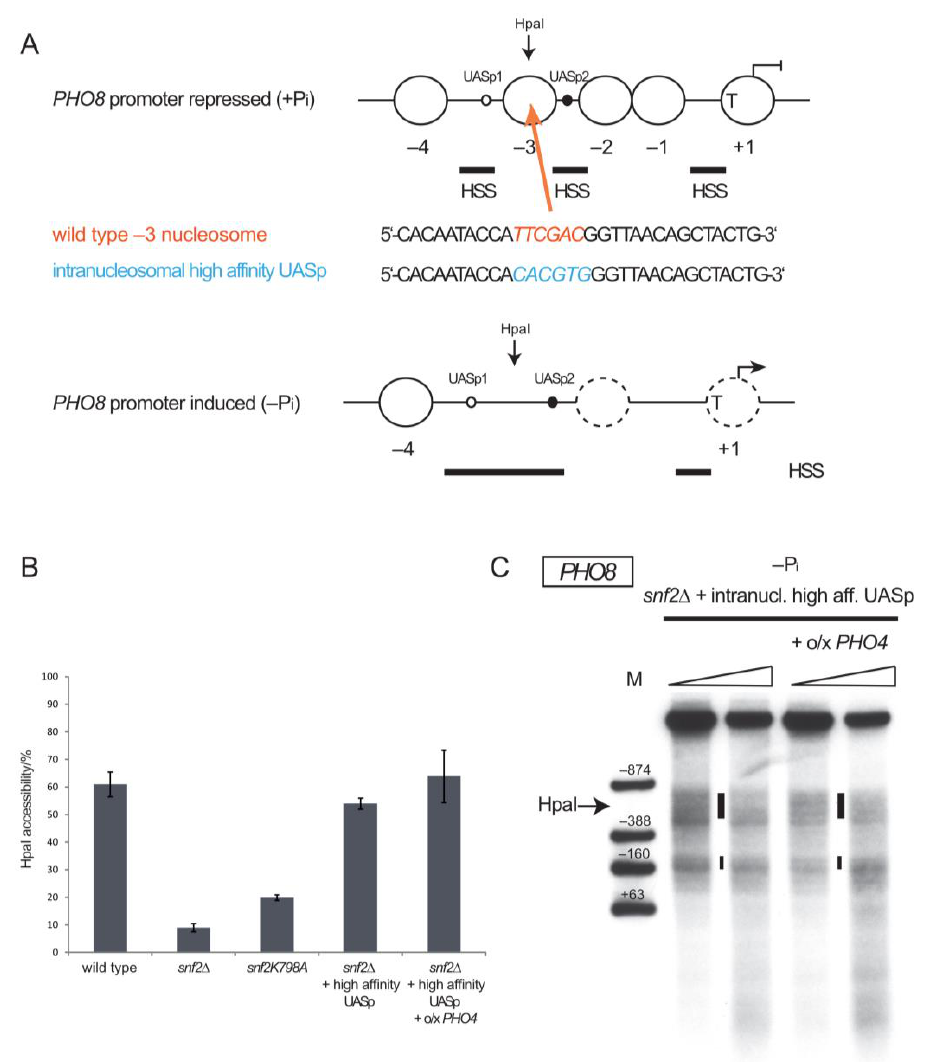
Figure 1. Introduction of an additional intranucleosomal high-affinity Pho4 binding site (UASp) allows nucleosome remodeling at the PHO8 promoter in the absence of SWI/SNF activity. ( A ) Schematics, approximately to scale, of the nucleosome organization at the PHO8 promoter in the repressed and induced state (broken arrows show direction and start of transcription in the repressed (blunt arrow) or induced (pointed arrow) state, respectively). Large open circles denote positioned nucleosomes, numbered relatively to transcription start. Horizontal bars represent hypersensitive sites (HSS), dashed circles ambiguous nucleosome organization, small circles high (closed small circles)- or low (open small circles)-affinity UASp and “T” the TATA box position. The position of the HpaI site used for restriction enzyme accessibility assays is indicated as well the position (colored arrow) where the new high-affinity UASp element was introduced in the − 3 nucleosome on a plasmid according to the indicated sequence changes. ( B ) HpaI accessibility values for the indicated genotypes, all after overnight incubation in phosphate-free medium ( − P i ). “high affinity UASp” stands for the newly introduced intranucleosomal UASp in the plasmid locus shown in panel A. “o/x PHO4 ” stands for PHO4 overexpression. Average values and error bars (standard deviation) derived from two or more biological replicates are shown. ( C ) DNaseI indirect end labeling for the PHO8 plasmid locus and indicated genotypes, all after overnight incubation in phosphate-free medium ( − P i ). Ramps on top of the lanes denote increasing DNaseI concentration. Vertical bars in-between lanes indicate hypersensitive regions. Marker fragments (lane M) were generated by double digests with EcoRV ( − 874 relative to PHO8 ATG) or NdeI ( − 388) or HindIII ( − 160) or SacI (+61) each with BglII (+571). The approximate position of the HpaI site is